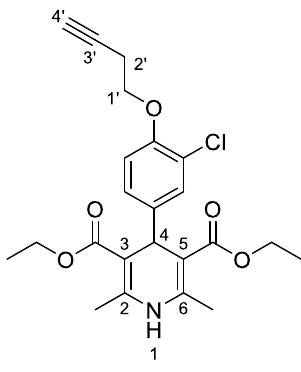
Figure 19. Chemical stucture of 3r .